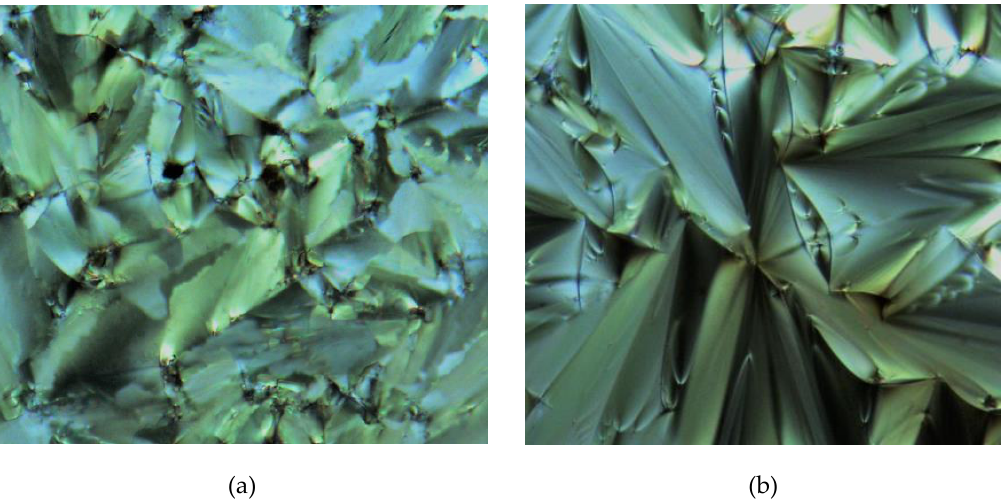
Figure 10. The optical photomicrographs of compound 4e in the cooling cycle, ( a ) SmA at 175.34 °C and ( b ) SmC at 143.76 °C (Magnification of 20 × 0.25).